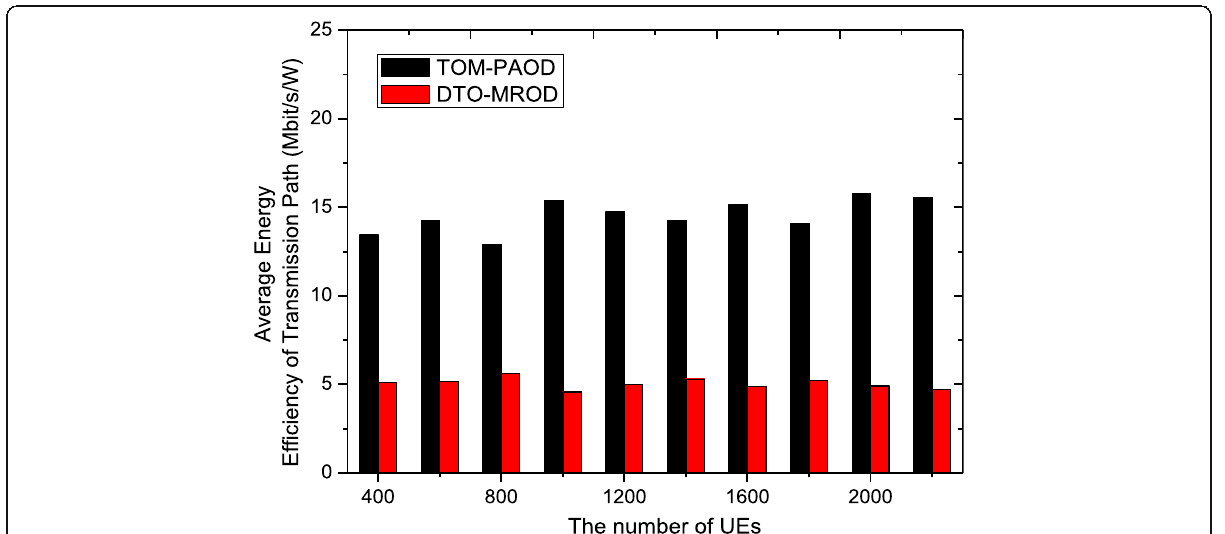
Fig. 6 Comparison of energy efficiency: variation trend of energy efficiency in the two schemes with the number of UEs in the given